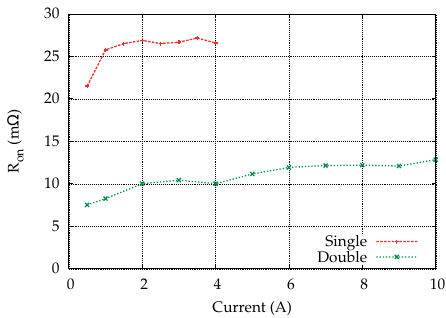
Figure 16. The measured on-resistance over the operating current range of the NIMBUS, for both a single chip and two parallel